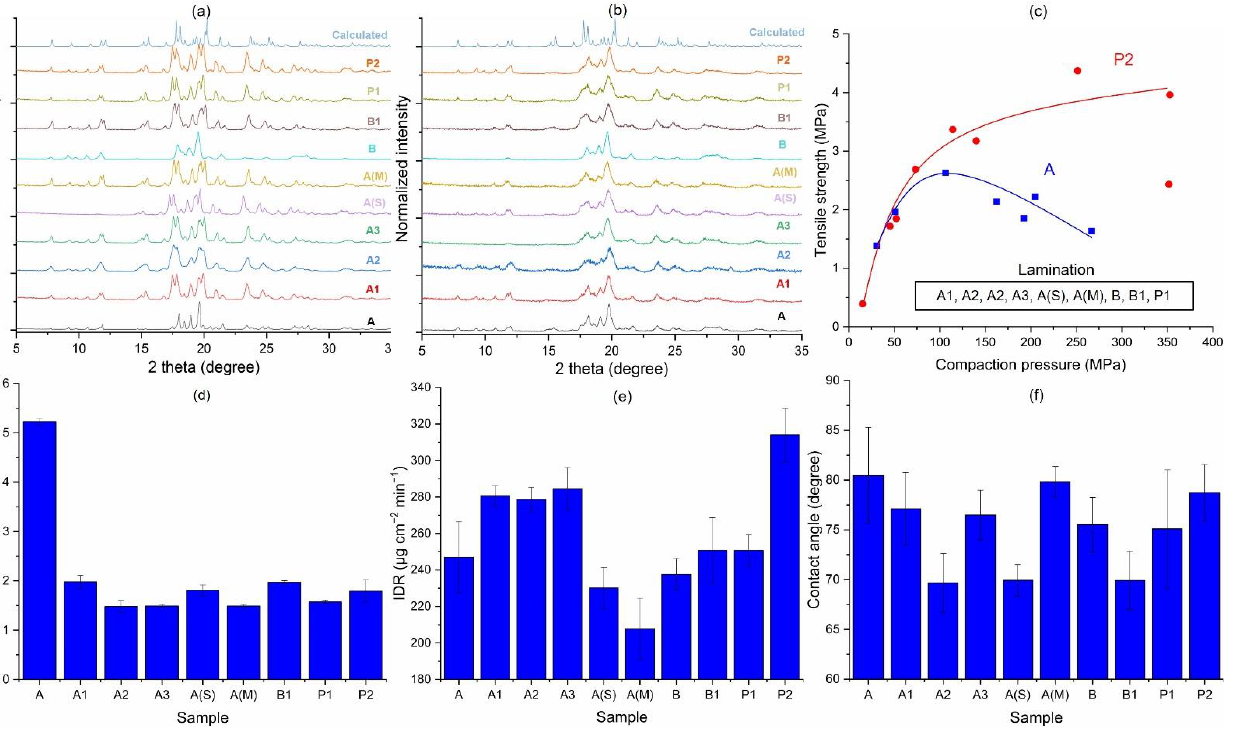
Figure 2. Solid-state properties and bulk powder properties of all Odanacatib samples. ( a ) Powder XRD; ( b ) tablet XRD; ( c ) tabletability; ( d ) flowability; ( e ) intrinsic dissolution rate; ( f ) contact angle.